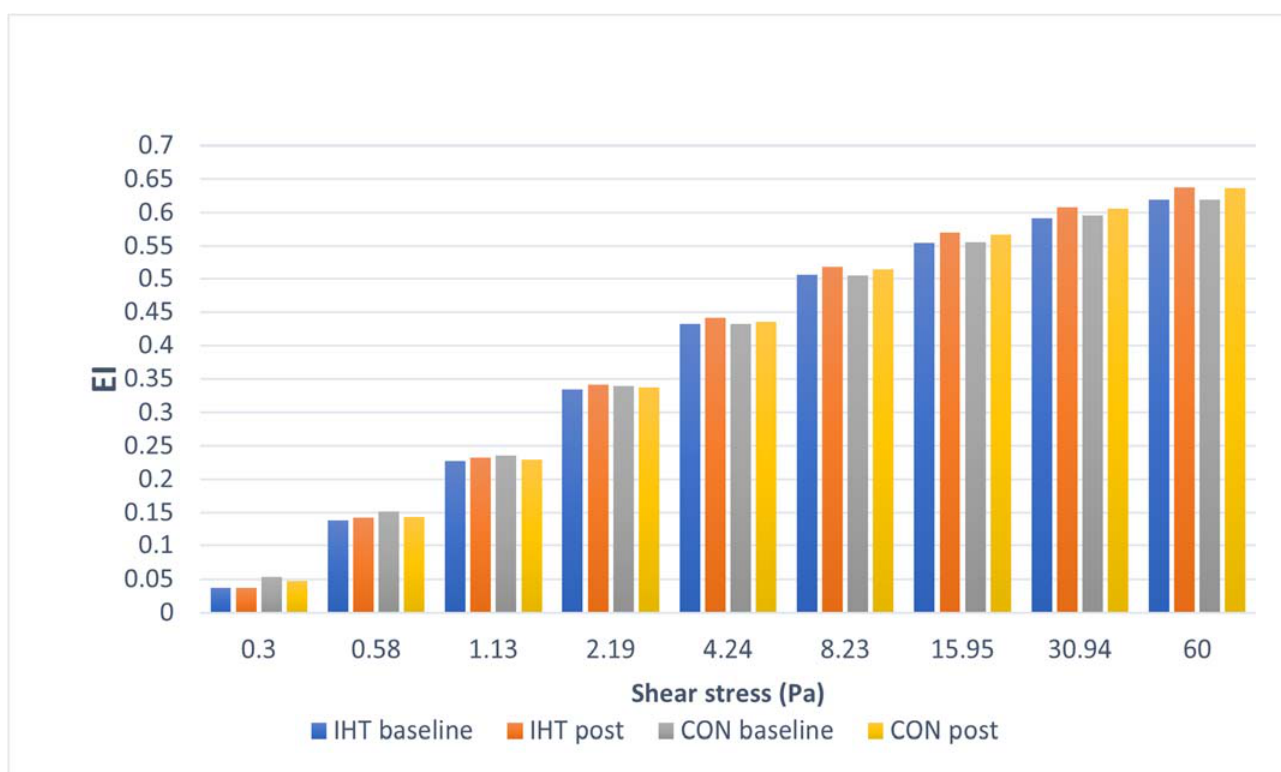
conditions before and after the intervention.